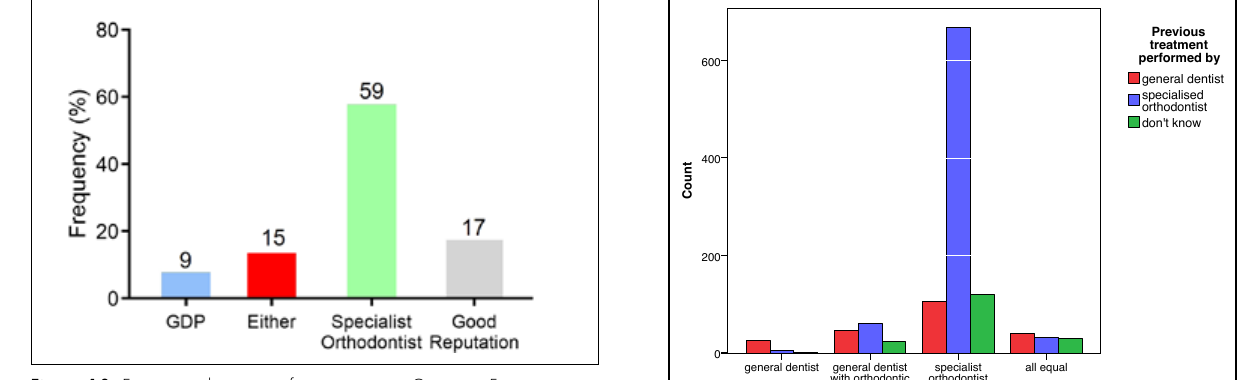
Figure 10. Frequency histogram for response to Question 5 assessing which practitioner the respondent felt most comfortable providing them with orthodontic treatment.